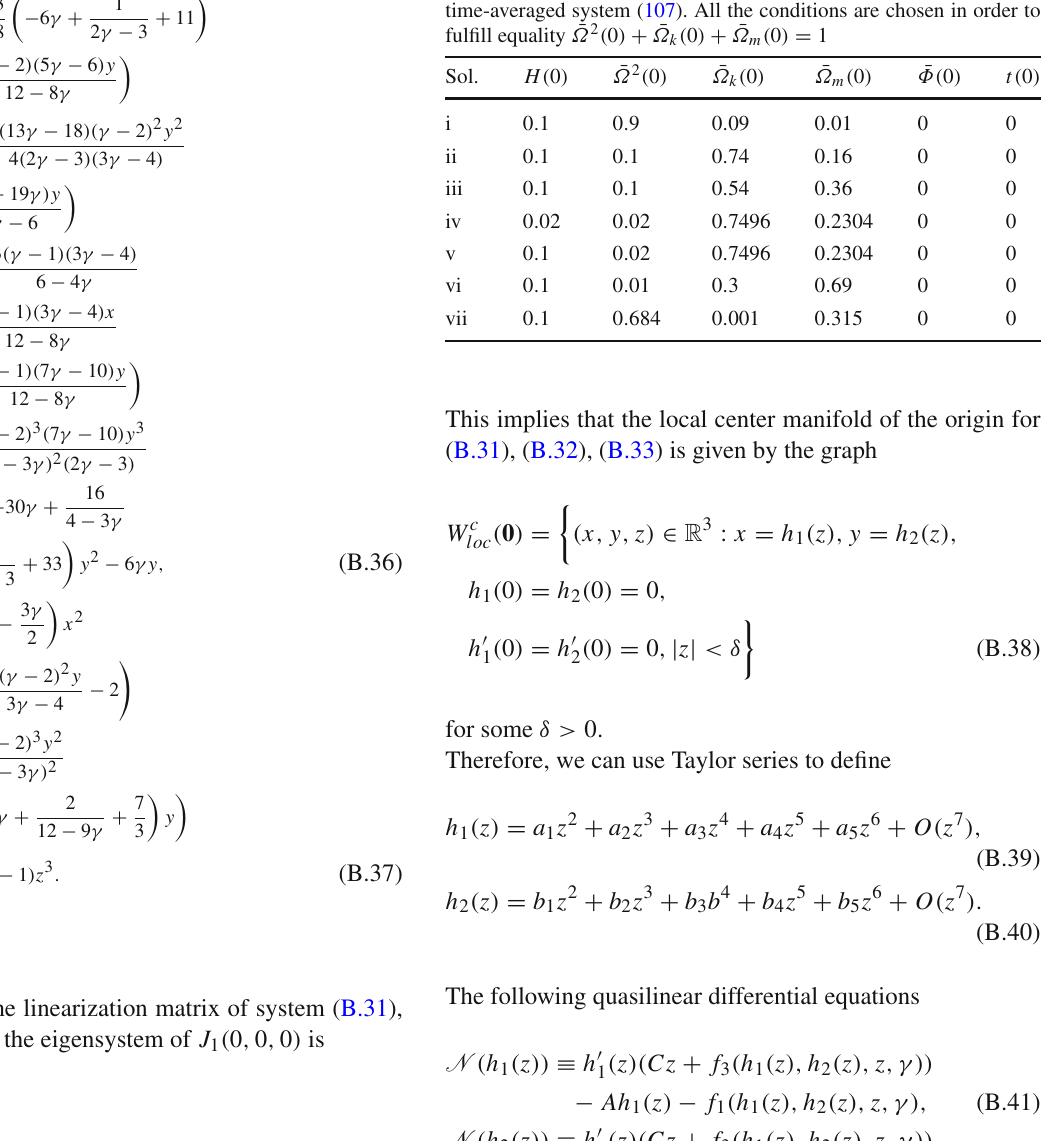
Table 4 Seven initial data sets for simulation of full system (71) and time-averaged system (107). All the conditions are chosen in order